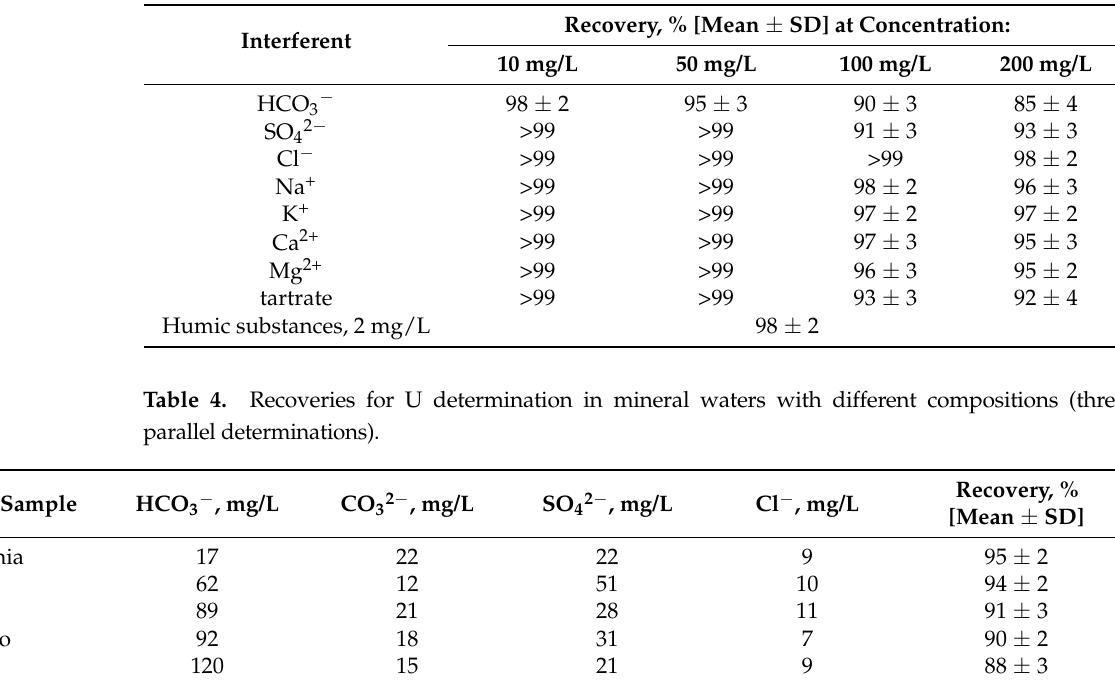
Table 3. Recoveries for U determination in the presence of different concentrations of major cations and anions in waters (three parallel determinations).